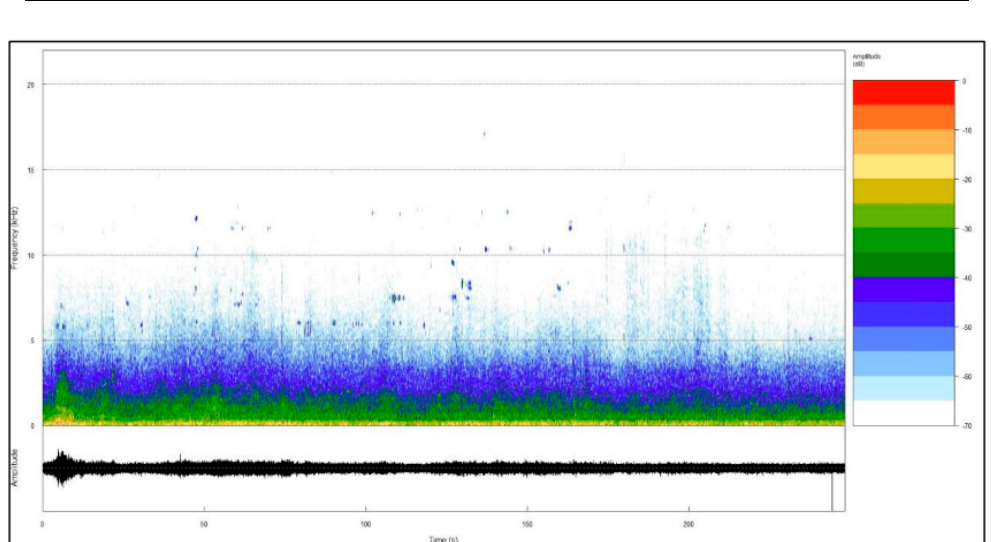
Figure 6. A graph showing levels of noise (dB) in Hagia Sophia Square.